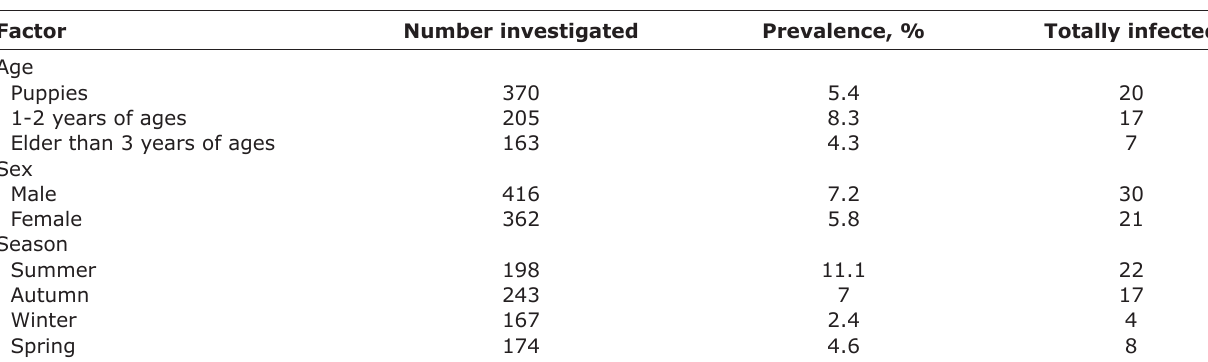
Table-1: The prevalence of Uncinaria stenocephala in